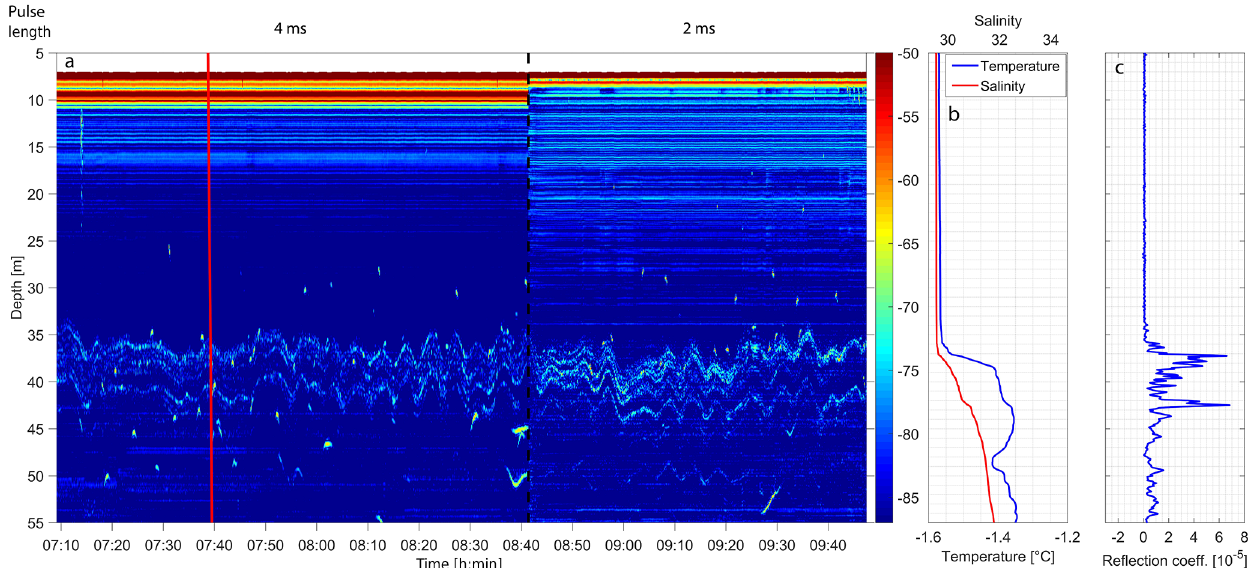
Figure 5. Tendency of increased range resolution in EK80 data with smaller pulse length. Data were acquired on 29 August 2016 at 148.1 ◦ W, 86.1 ◦ N. (a) EK80 echogram with backscatter strength in dB on the color bar. (b) CTD profiles showing temperature (blue) and salinity (red). (c) Reflection coefficients derived from CTD data. Note that, as there is no ground-truth CTD cast within the later section of the echogram, there might be splitting and merging of layers (as shown in Stranne et al., 2017) and other changes in the stratification behavior occurring near the change in pulse